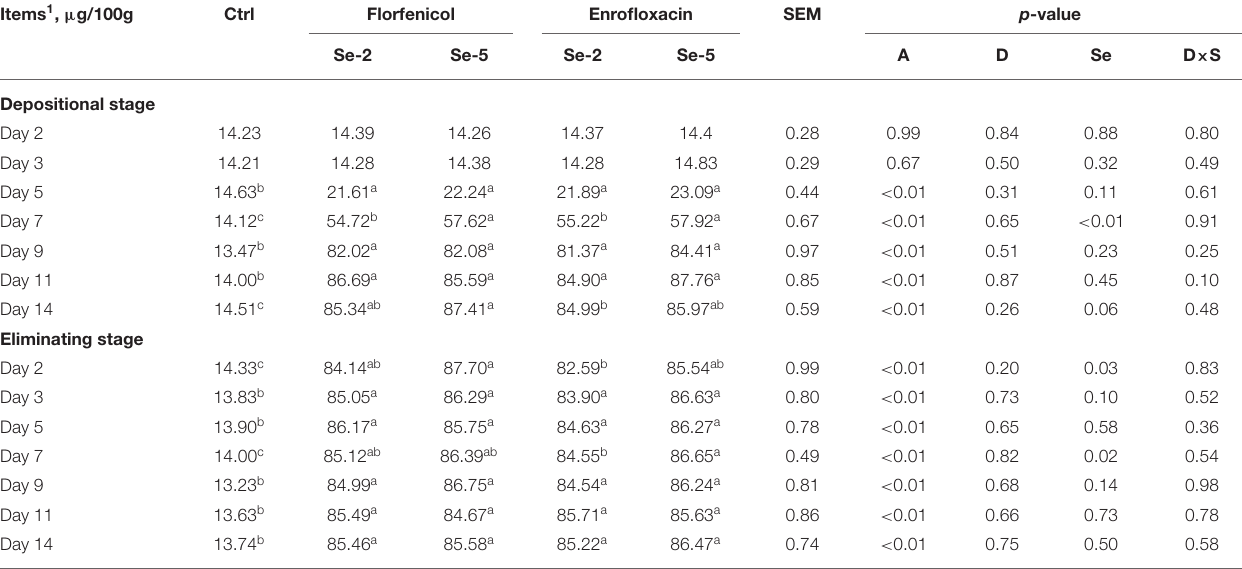
TABLE 11 | Effects of dietary organic selenium and drugs on the concentration of selenium in whole egg of laying hens. Items 1 , µ g/100g Ctrl Florfenicol Enrofloxacin SEM p -value Se-2 Se-5 Se-2 Se-5 A D Se D ×